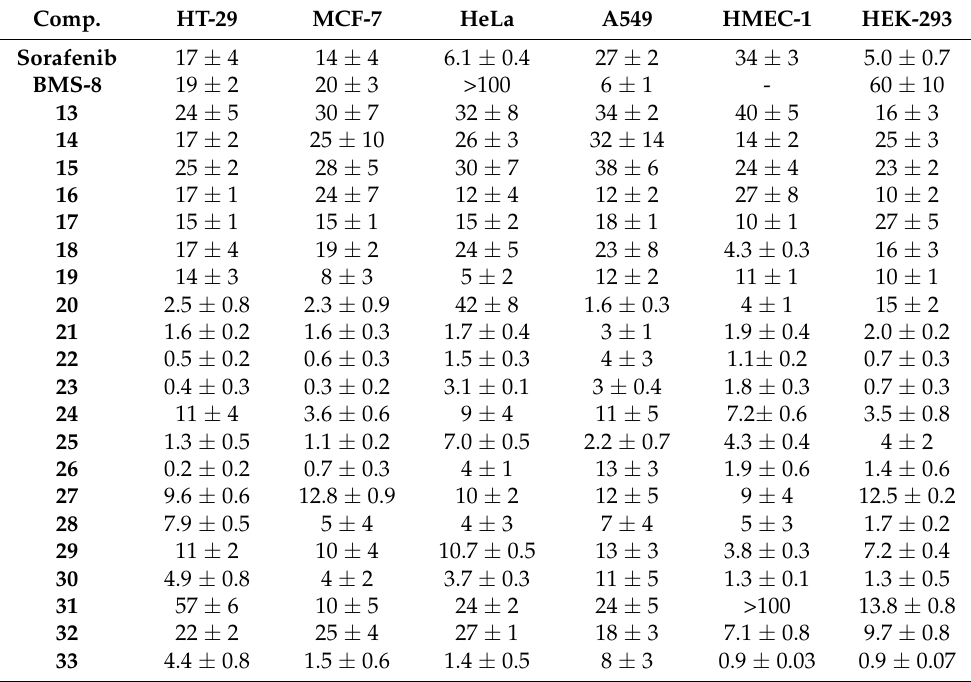
Table 1. IC 50 values ( µ M) for sorafenib, BMS-8 and Derivatives 13–33.